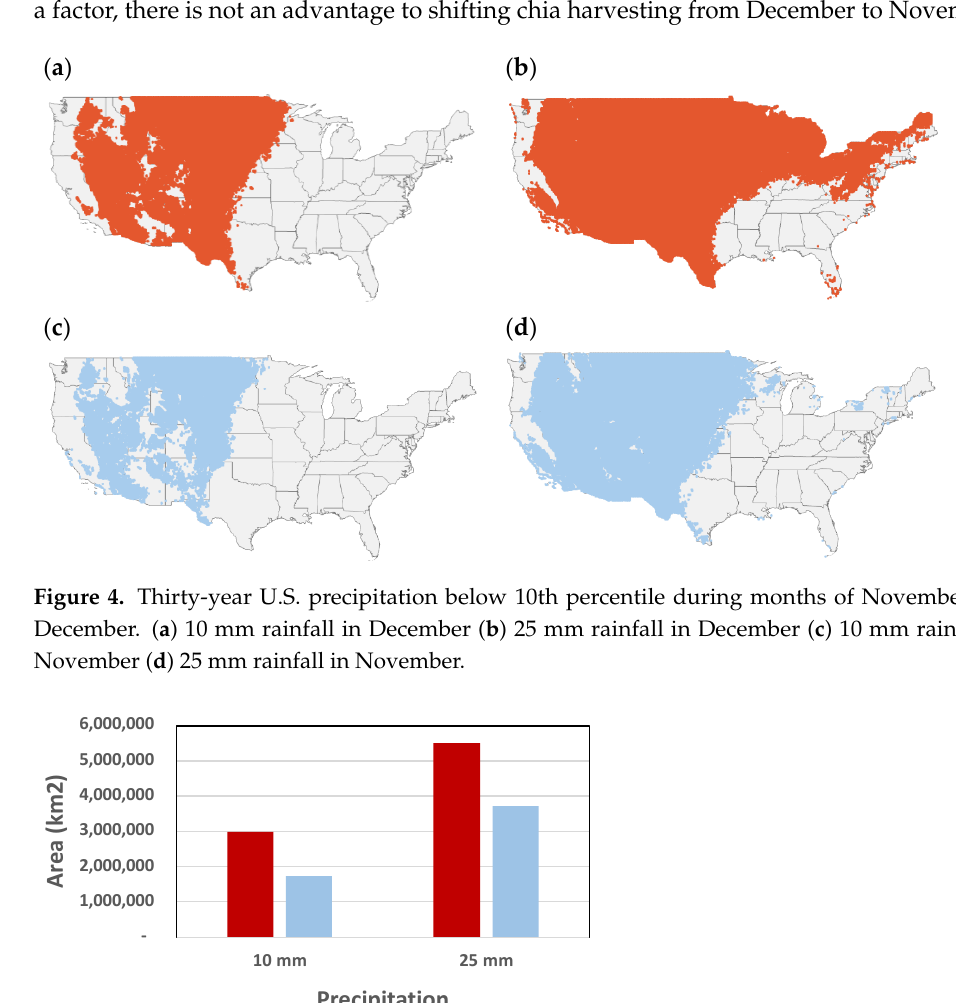
Figure 5. Comparison of areas in Figure 4a – d.